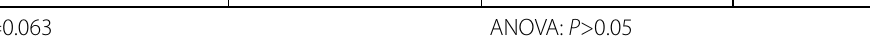
Table 3. Means and standard deviations in time (months) elapsed between treatment and findings on last CT scan. Without